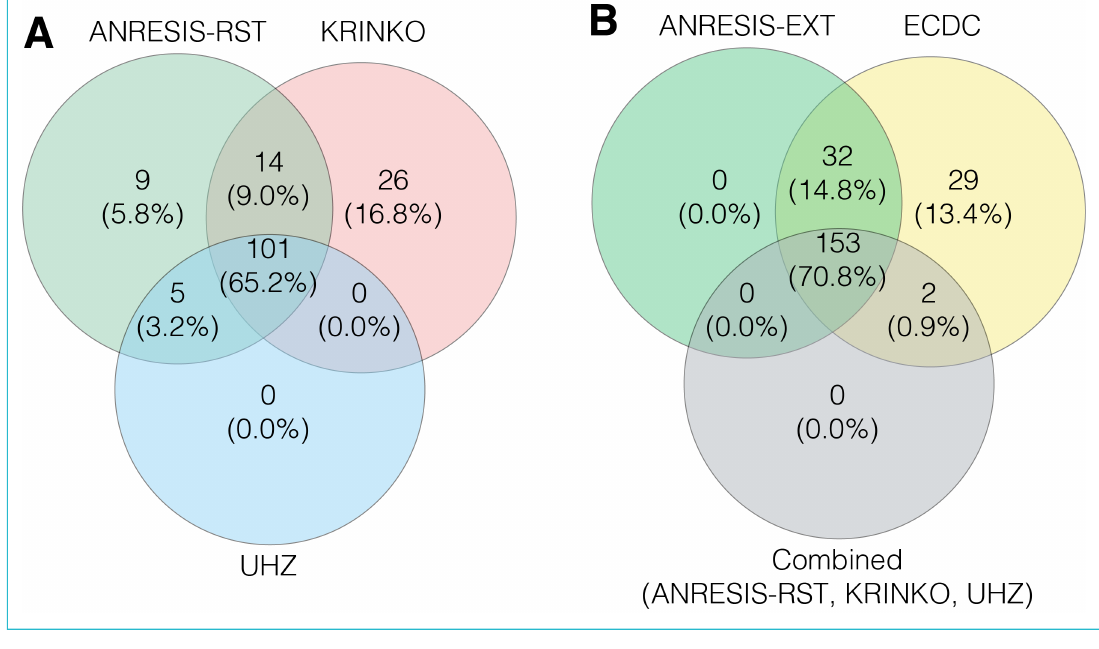
Figure S5: A) Overlap in the number of Pseudomonas aeruginosa isolates classified as MDR following the application of the KRINKO, UHZ and ANRESIS-RST definitions. B) Overlap in the number of Pseudomonas aeruginosa isolates classified as MDR after application of the ECDC, ANRESIS-EXT definition and the combined MDR cases found with the KRINKO, UHZ and ANRESIS-RST definition. MDR, multiple drug resistance; ECDC, European Centre for Disease Prevention and Control; KRINKO, Commission for Hospital Hygiene and Infection Pre- vention; UHZ, University Hospital Zurich; ANRESIS, Swiss Centre for Antibiotic Resistance; RST, restricted; EXT, extended.